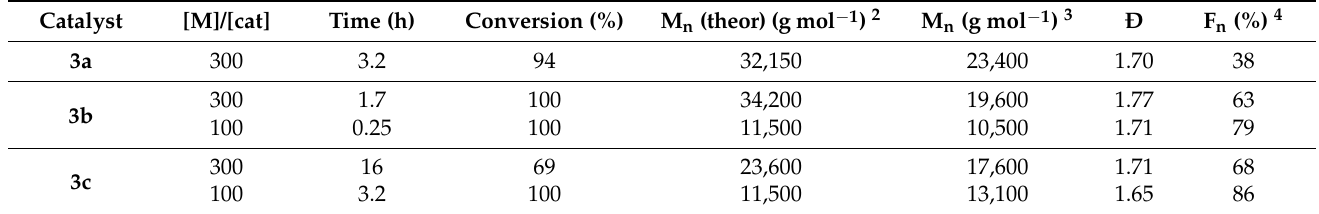
Figure 3. ( a ) ln[ M ] 0 /[ M ] vs. time; ( b ) M n , Ð vs. conversion dependences for the bulk ε -caprolactone polymerization in the presence of different catalytic complexes at [ M ]/[catalyst] = 300 and at 80 ° C. The straight line in Figure 3b corresponds to the theoretical molecular weight calculated as M n (theor) = ([ ε -caprolactone]/[catalyst]) × 114 × Conversion + 115. Experimental values of the molecular weight determined by SEC versus polystyrene standards were corrected by a factor of 0.52 [85]. Table 1. Bulk ROP of ε -caprolactone at different monomer to catalyst ratios 1